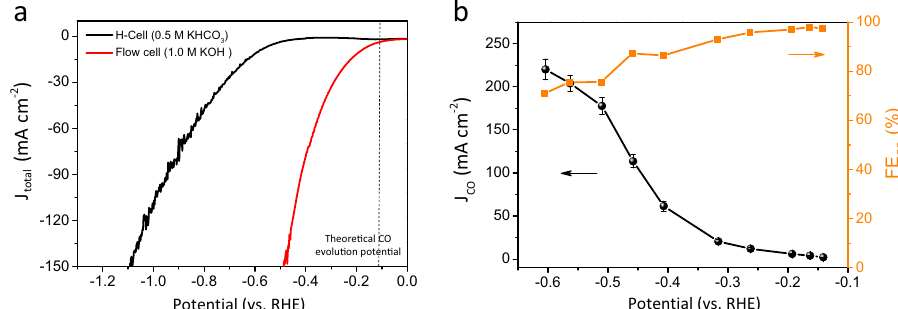
Fig. 4 CO 2 electrolysis on Cu 97 Sn 3 in a fl ow cell. a Polarisation curves obtained at a scan rate of 10 mV s − 1 for the H-cell and the fl ow cell. b CO FEs and current densities at different